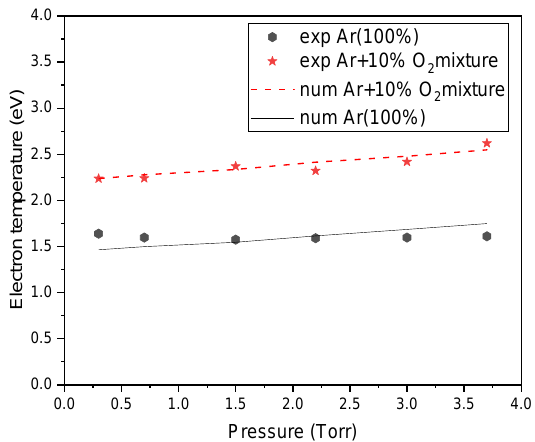
Figure 3. Variation of electron temperature with pressure in RF glow discharge. The solid and dotted lines represent the model calculations in pure argon and in the (Ar + 10% O 2 ) mixture. The experimental measurements were carried out with Langmuir probes [37].